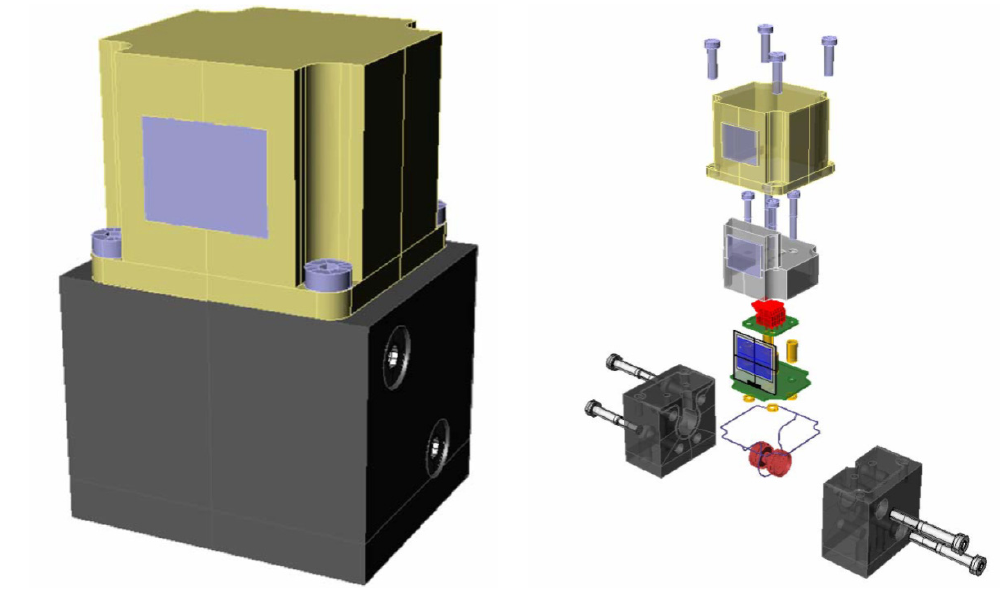
Figure 10. Industrial grade packaging for the target